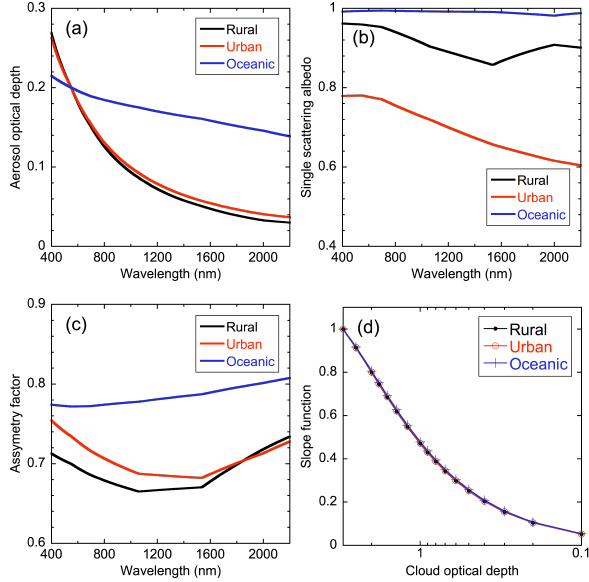
Fig. 3. Optical depth (a) , single scattering albedo (b) , and assymetry factor (c) for rural (black), urban (red), and oceanic (blue) aerosols, used in the sensitivity test. (d) Corresponding slope functions derived from simulations at 400–870nm.